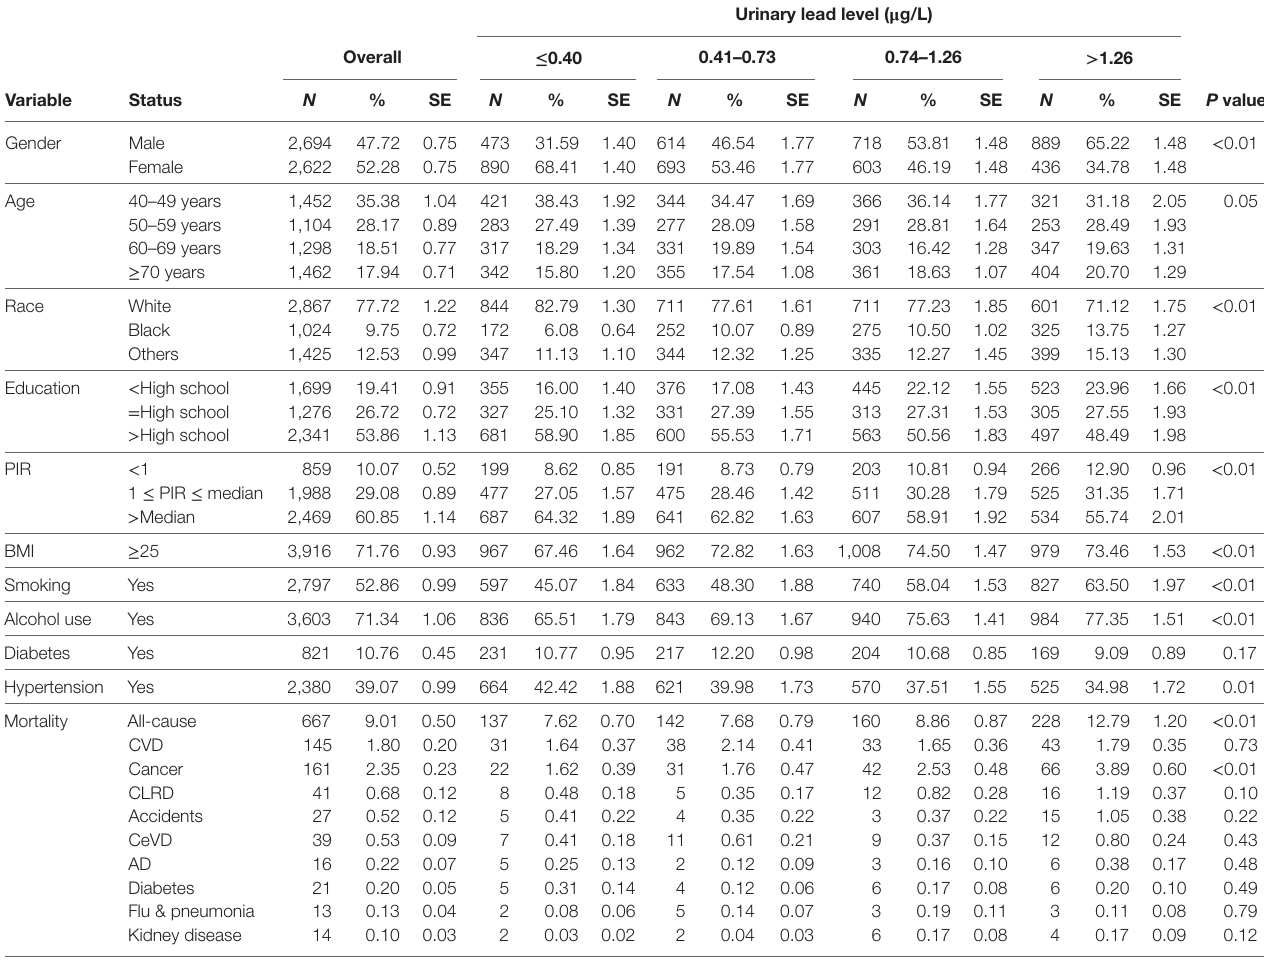
TaBle 1 | Weighted characteristics of the study population by urinary lead level-NHANES 1999–2010.